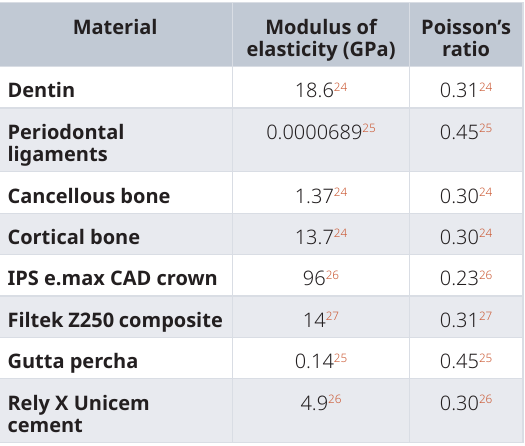
Table 2. Physical properties of each component of the model.